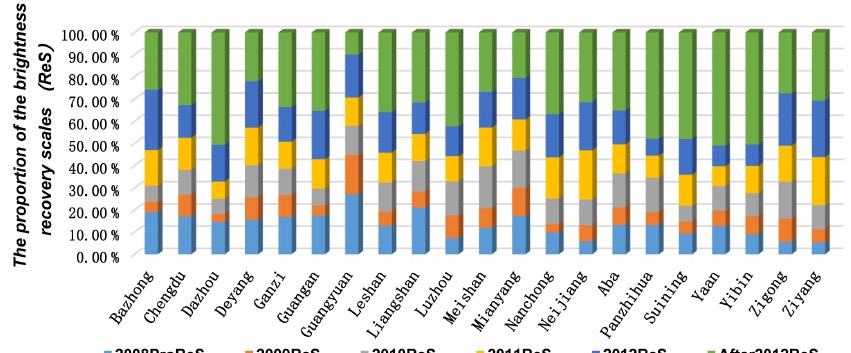
expansion area of nighttime light in 2008, green represents the expansion area of nighttime light in 2009, cyan repre- sents the expansion area of nighttime light in 2010, purple represents the expansion area of nighttime light in 2011 and red represents the expansion area of nighttime light in